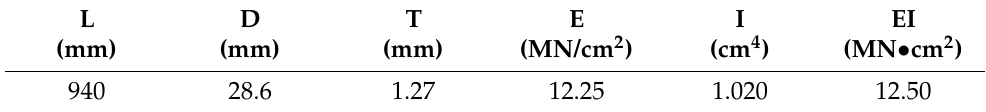
Table 2. Characteristics of model pile.